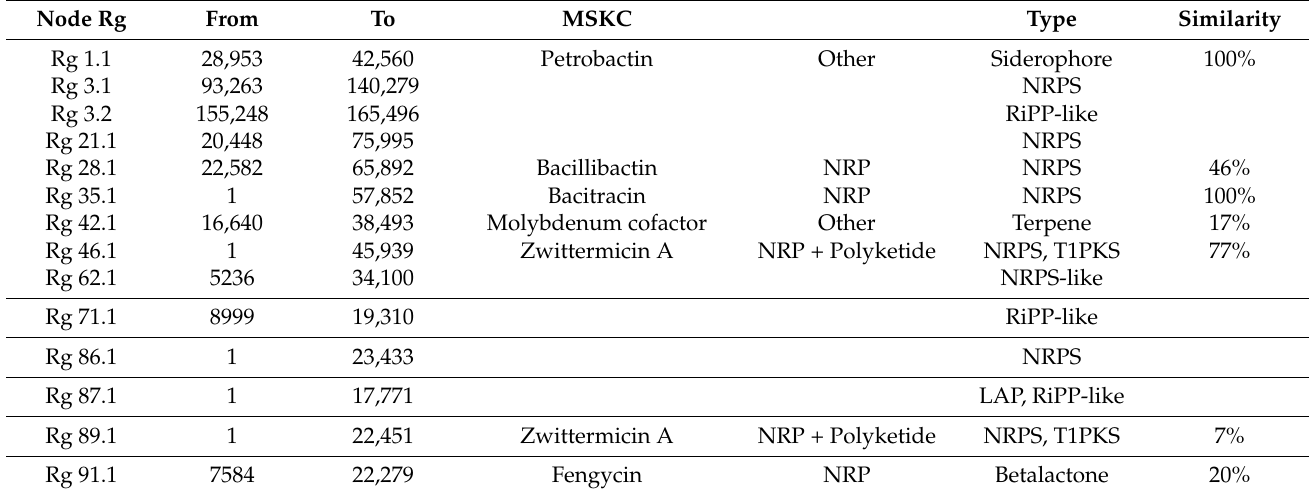
Table 6. Estimate of secondary metabolite genes in genome of B. cereus T4S.